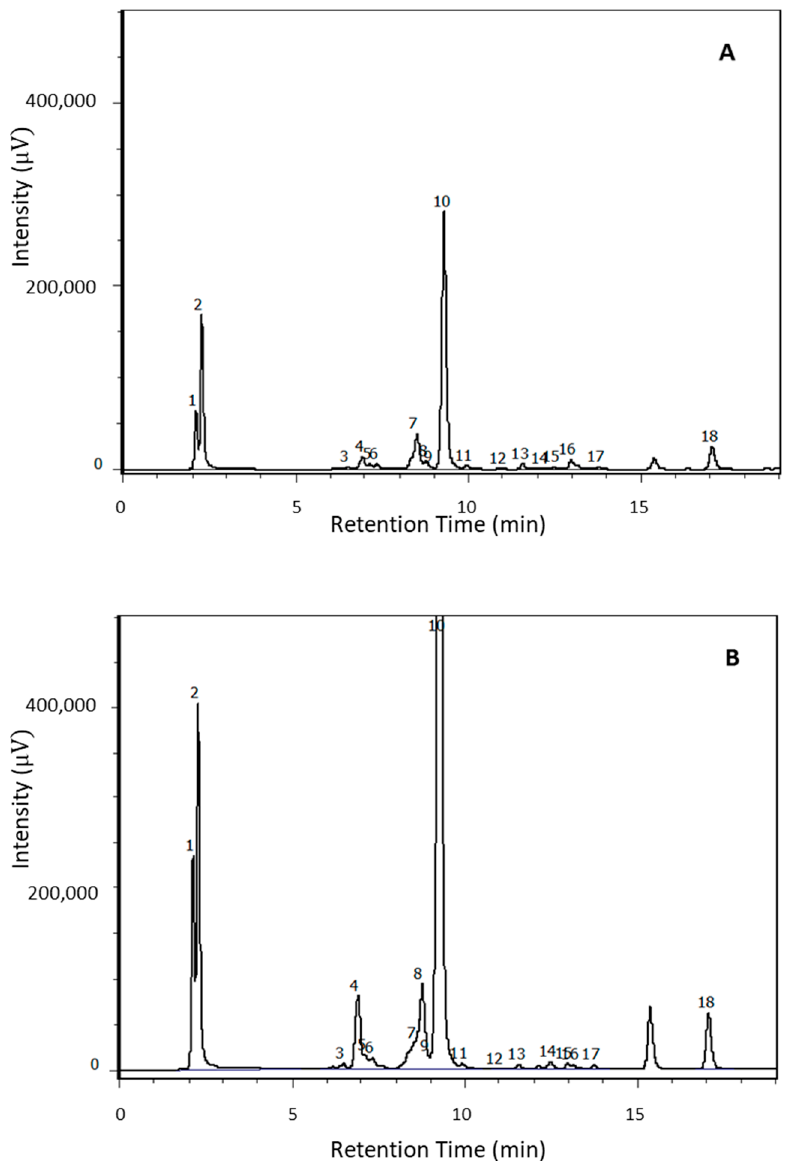
Figure 5. ( A ) HPLC/FLD chromatograms of OTA2 tea extract at the concentration of 0.5 mg/mL. ( B ) HPLC/FLD chromatograms of GT5 tea extract at the concentration of 0.5 mg/mL. The analysis showed the presence of (1) aspartic acid; (2) glutamic acid; (3) serine; (4) glutamine; (5) glycine; (6) threonine; (7) alanine; (8) arginine; (9) GABA 1; (10) theanine; (11) tyrosine; (12) cysteine; (13) valine; (14) GABA 2; (15) phenylalanine; (16) isoleucine; (17) leucine; (18) proline.